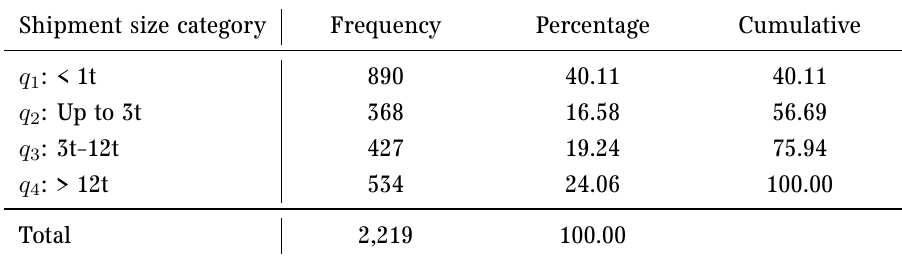
Table 3: Shipment size categories (2,219 observations).